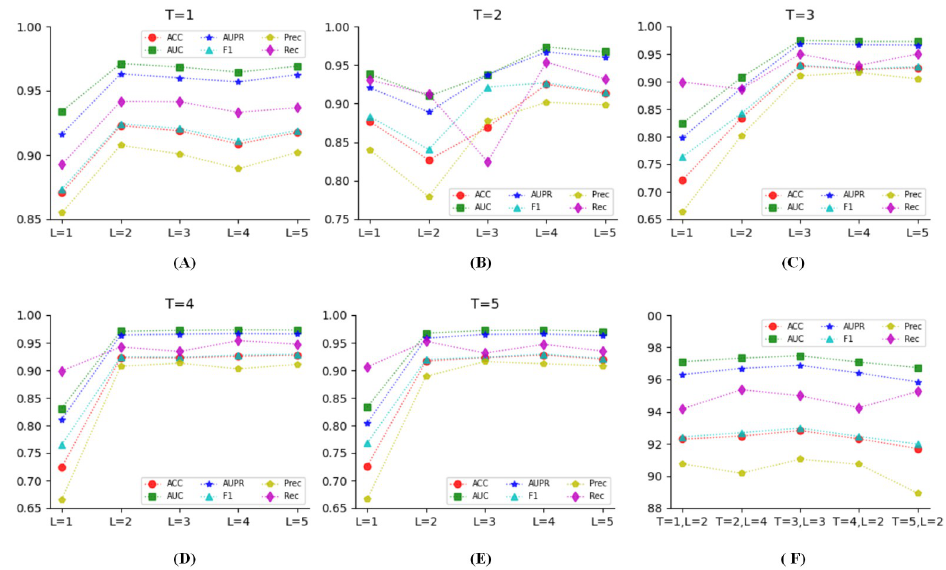
Fig 4. The effects of steps T and layers L .